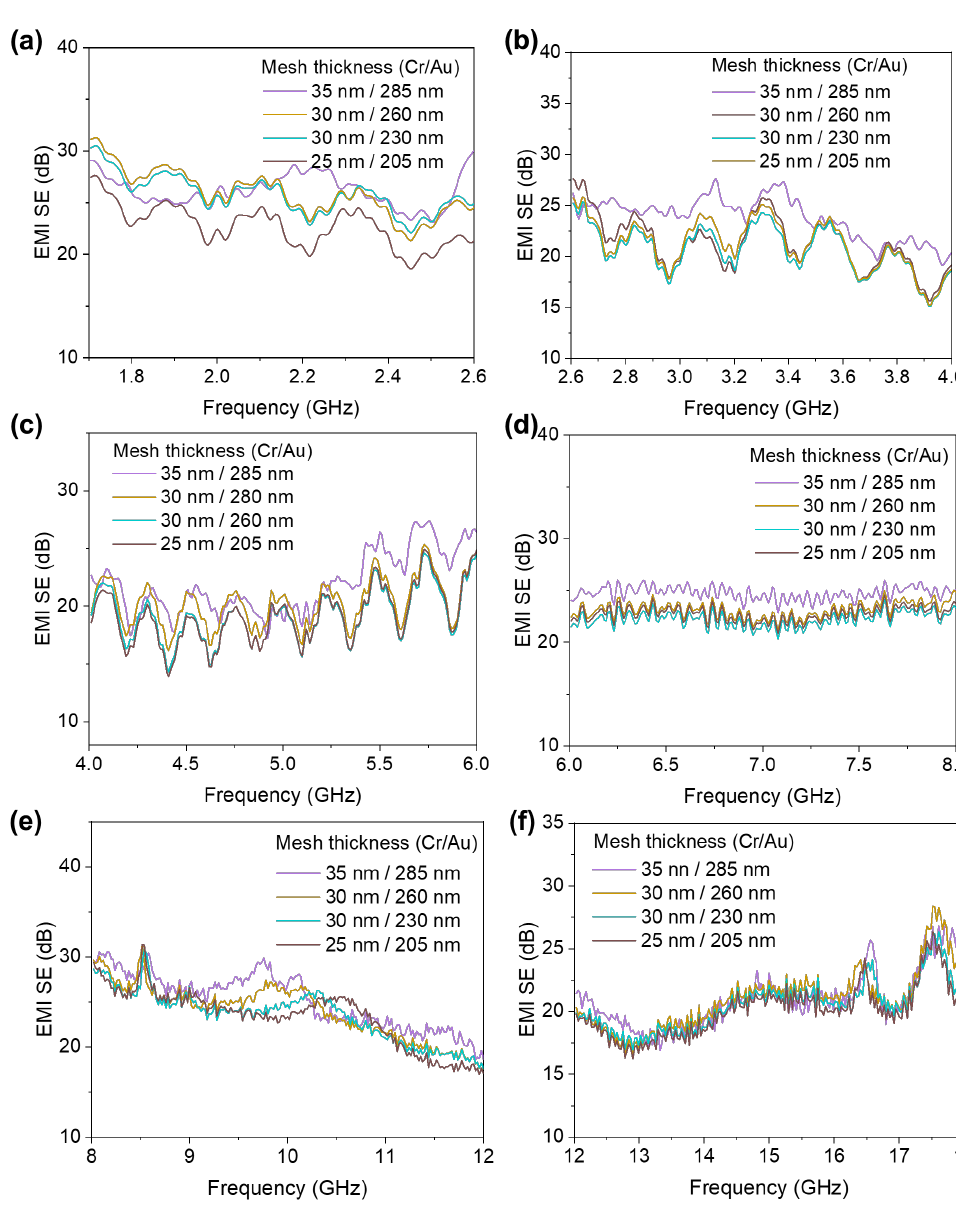
Figure 5. EMI shielding performance of metallic meshes with different thickness in varying frequency band. ( a ) 1.7–2.6 GHz. ( b ) 2.6–4 GHz. ( c ) 4–6 GHz. ( d ) 6–8 GHz. ( e ) 8–12 GHz. ( f ) 12–18 GHz. Table 1. Summary of average SE of meshes with varying thickness in each frequency band .